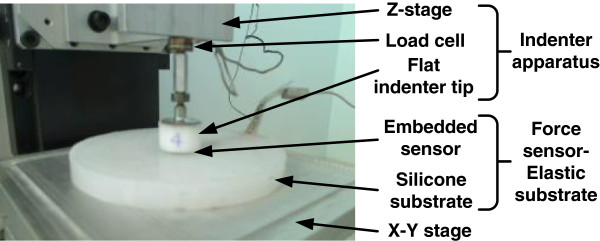
Set-up of indenter apparatus and force sensor-elastic substrate. The force sensor mimics the SAI mechanoreceptor inside the skin, while the load cell measures applied force at the indenter tip.